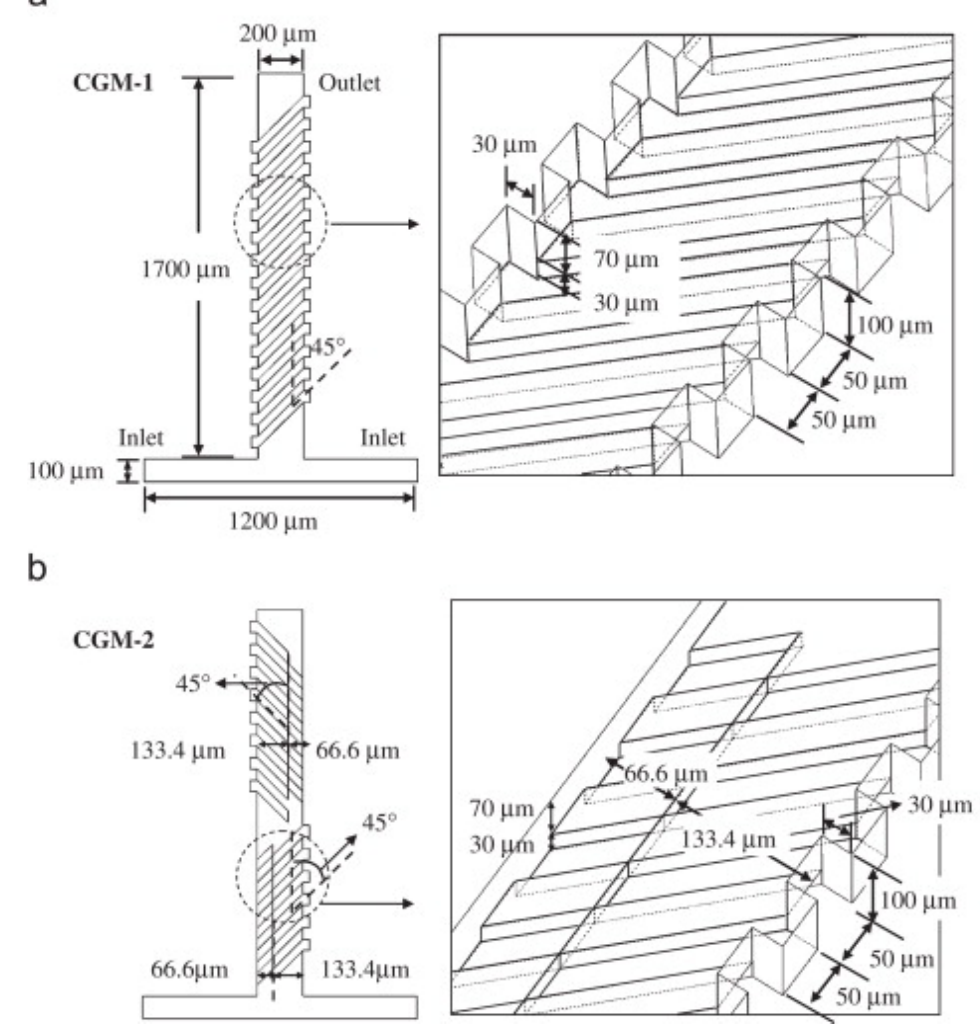
Figure 17. Schematic of the two channel designs of CGM (connected-groove micromixer) with not only bottom but also side grooves: (a) CGM-1 design; (b) CGM-2 design (from Yang et al. [34]).